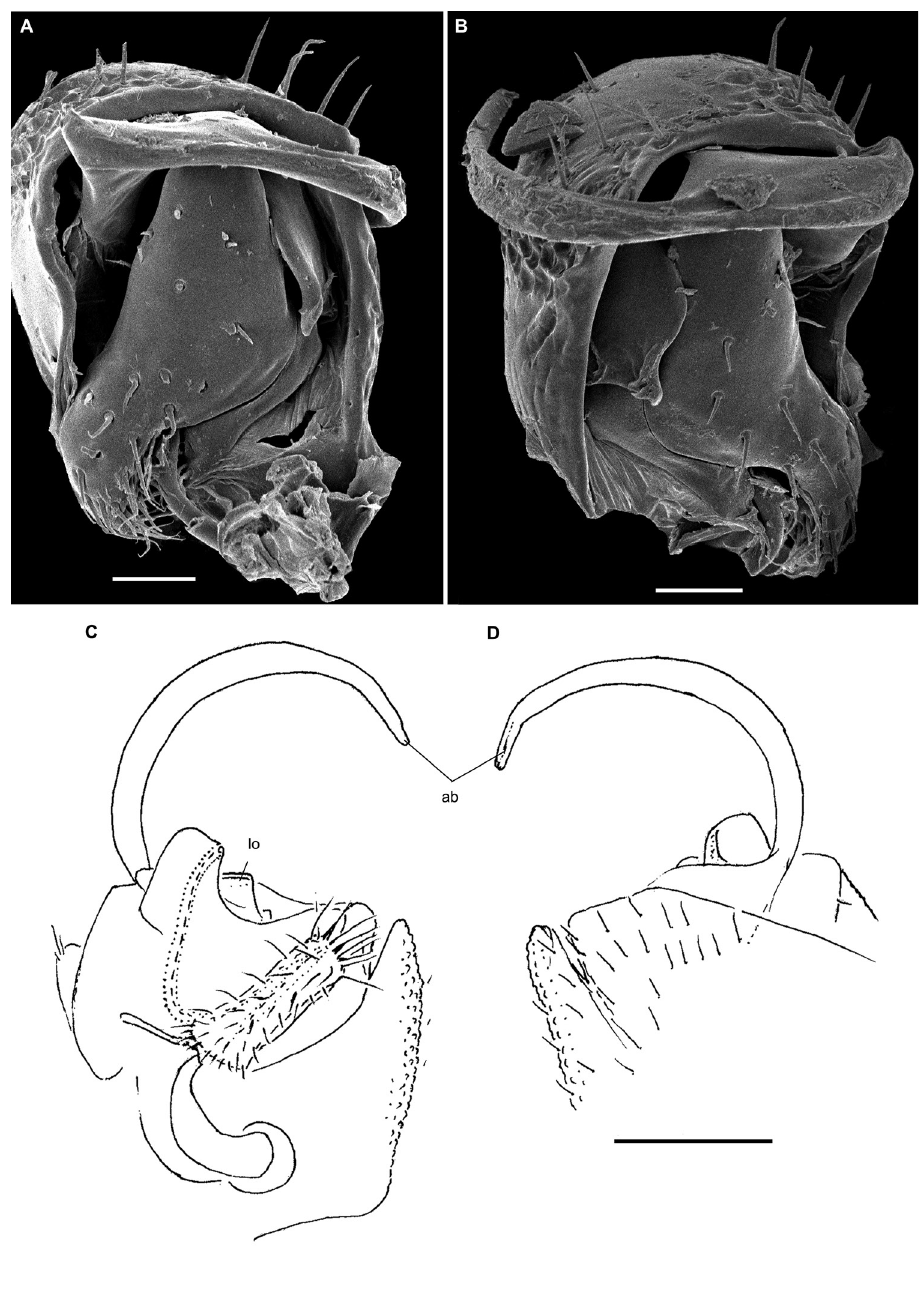
Figure 24. Hemisphaeroparia falcata sp. n., ♂ paratypes A, B SEM micrographs of left gonopod, ven- tromesal and submesal views, respectively C, D left gonopod, mesal and lateral views, respectively. Scale bars: 0.1 mm ( C, D ), 0.02 mm ( A, B ). Abbreviations: ab apical branch of telopodite, lo